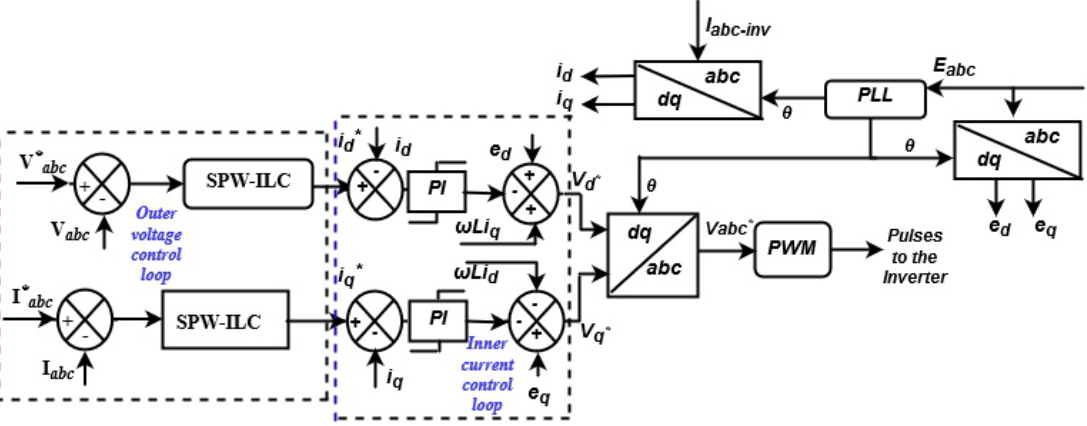
Figure 14. Control circuit for inverter of Aichi Micro grid system.